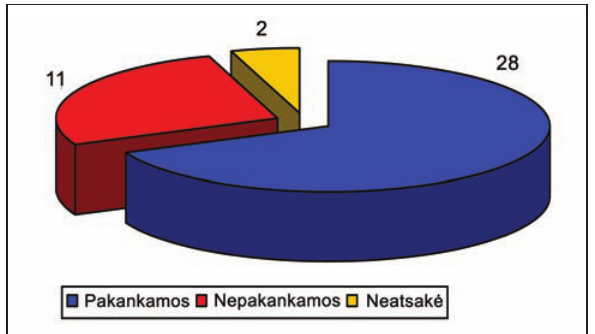
13 pav . Vilniaus miesto ávaizdþio vertinimas pagal ekspertø apklausos rezultatus 2005 m. Fig 13. Assessment of Vilnius city image according to the experts’ poll results, 2005